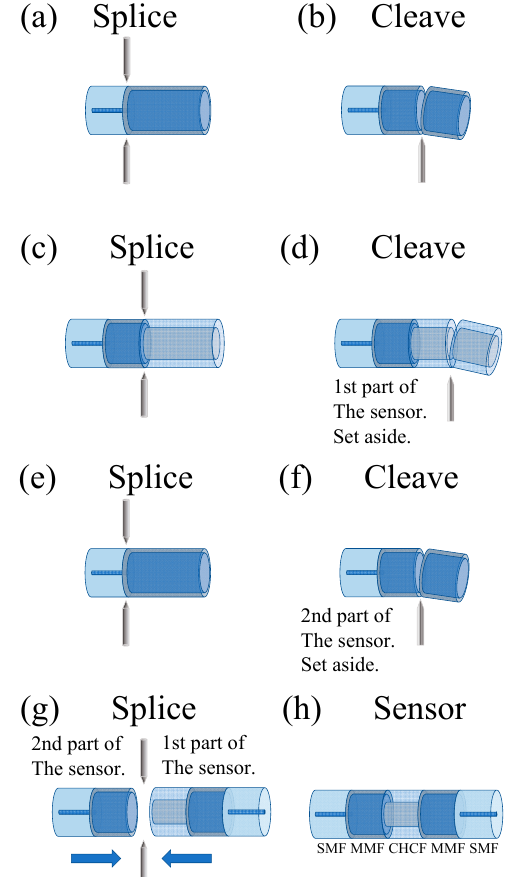
Figure 9. The fabrication process of the MZI: Fabrication of the first part ( a – d ), Fabrication of the second part ( e ) and ( f ), Assembly of the MZI ( g ) and ( h ).